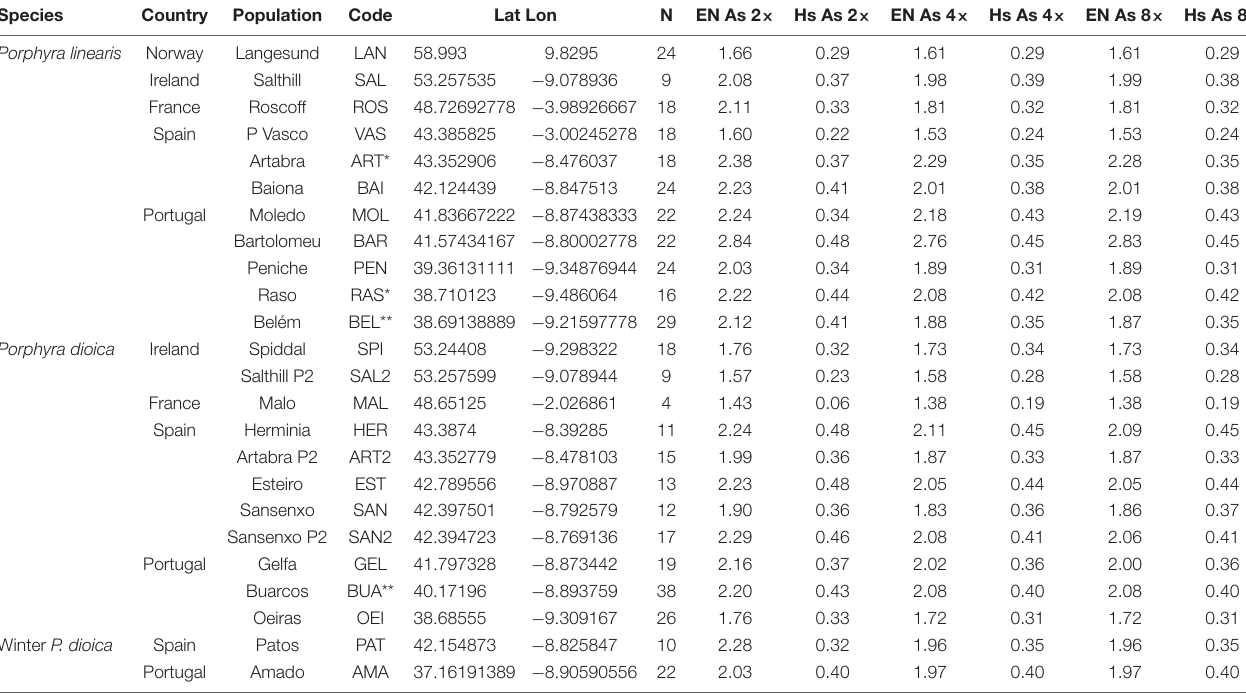
TABLE 1 | Geographic origin and nuclear genetic diversity of populations of P. linearis , P. dioica and the winter form of P. dioica used in this study. Species Country Population Porphyra linearis Norway